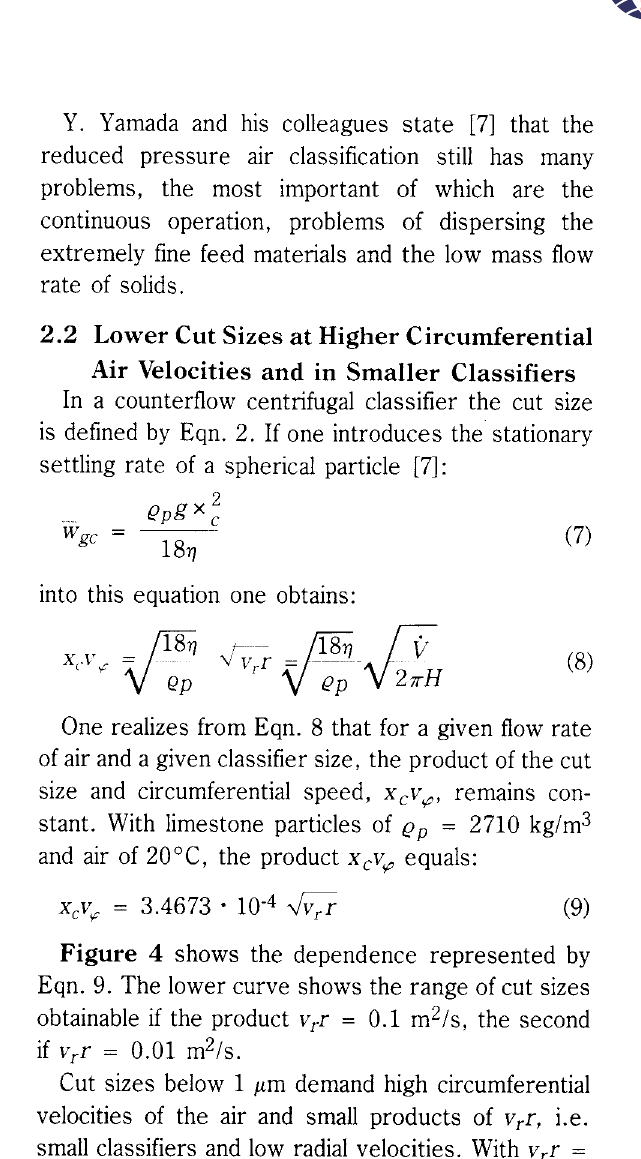
Fig. 2 Cunningham-correction : Cu = f (xp)